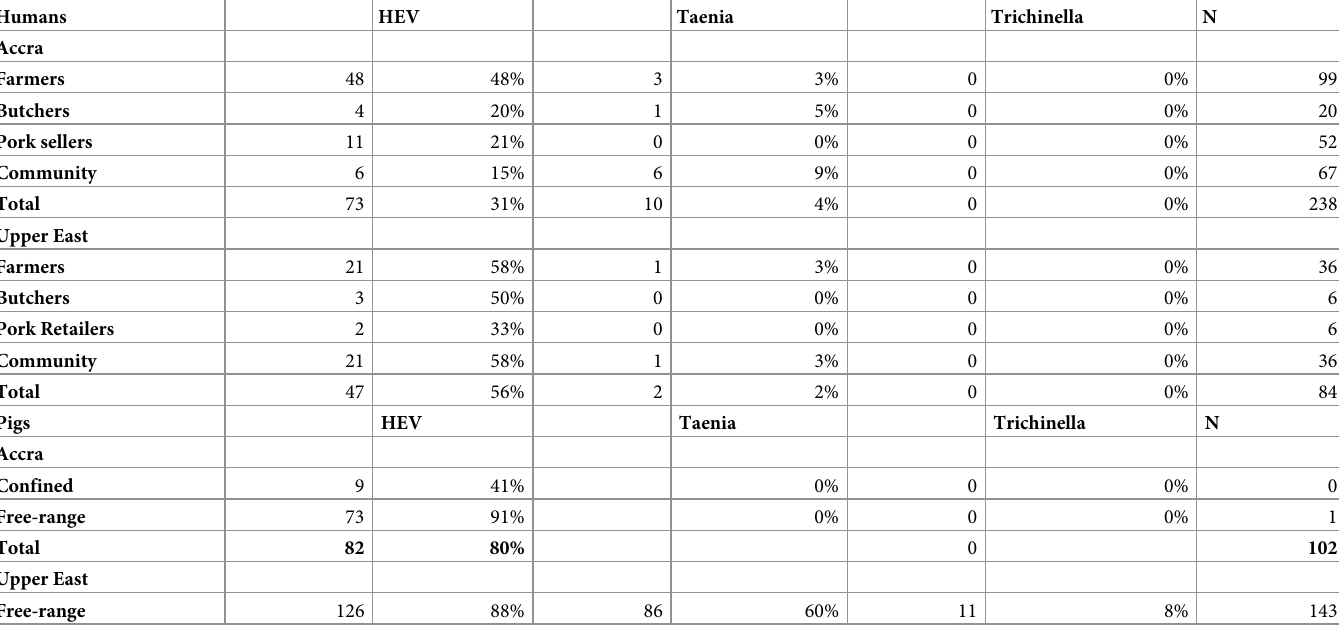
Table 5. Seroprevalence of pig-related